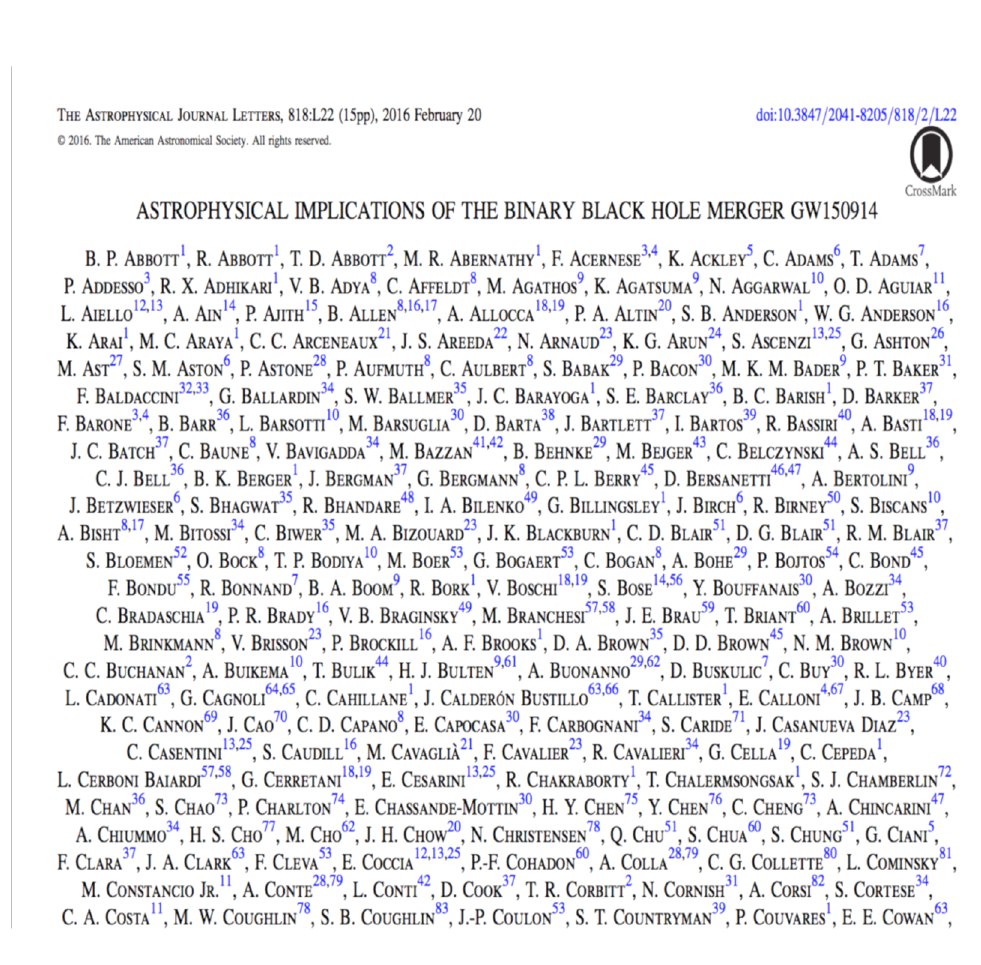
Figure 1. Sample of authorship on a scientific